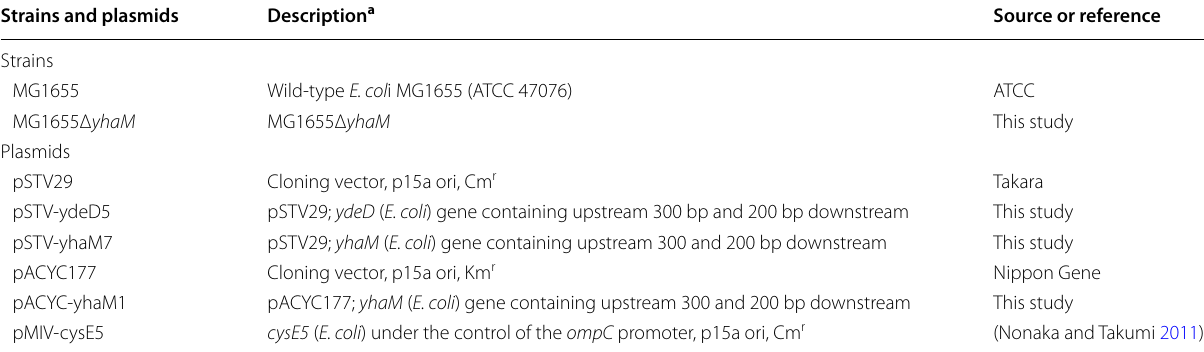
Table 1 Strains and plasmids